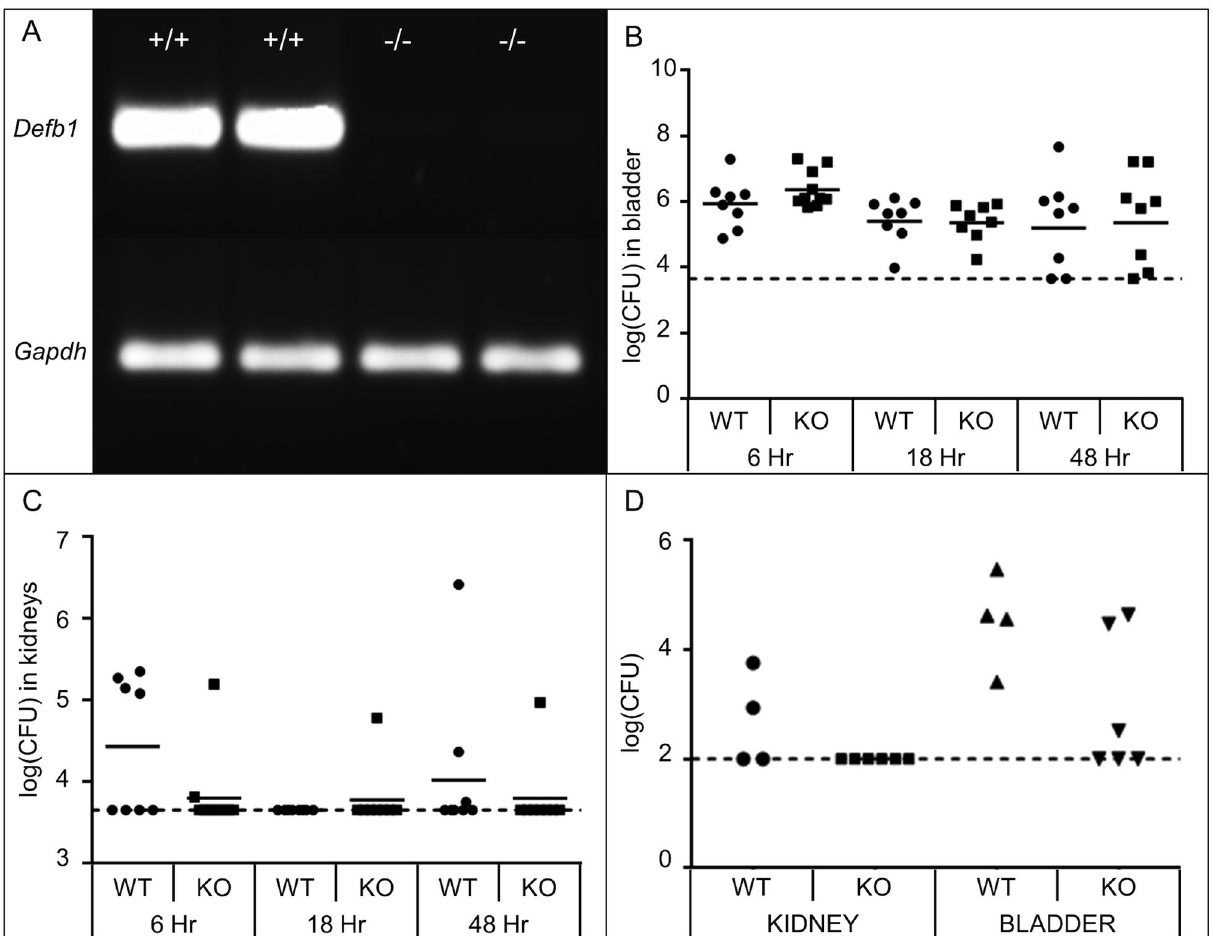
Figure 2. Effect of Defb1 deficiency on UPEC burden. (A) RT-PCR confirms absent expression of Defb1 mRNA in kidneys of Defb1 -/- mice (-/-, n=2), versus presence of the predict PCR product in wild type kidneys (+/+). Gapdh RT-PCR is included as a loading control. (B) Bacterial burden in bladders and kidneys of wild type (WT) versus Defb1 -/- (knockout, KO) mice at